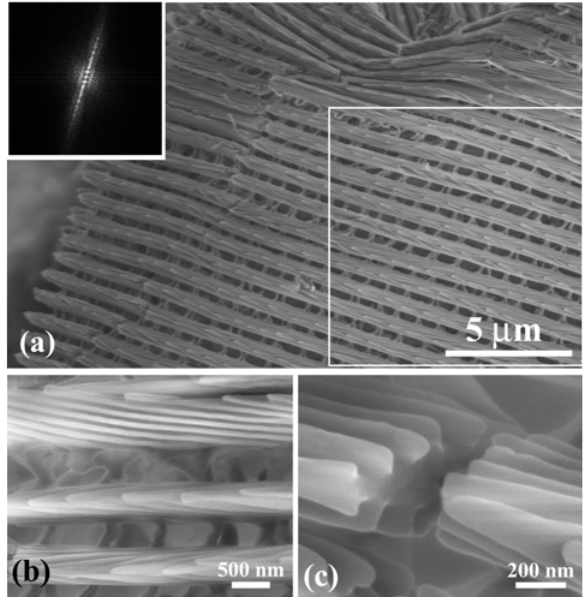
Figure 6. ( a ) SEM image of a W scale removed from the white patch in the male S. charonda wing. The inset is a computer diffractogram from the area enclosed by the square; ( b ) The side view and top view of the cuticles piled on the ridges; ( c ) The cross-sectional view of cuticle layers. B scales in the purple-blue iridescent area have the same microstructure (adapted from